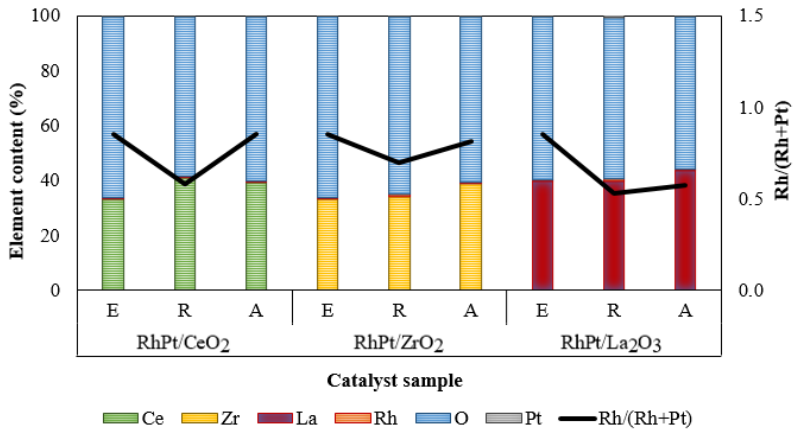
Figure 5. Energy dispersive X-ray microanalysis (EDX) of the catalyst samples by the average of three measurements over a 50 nm